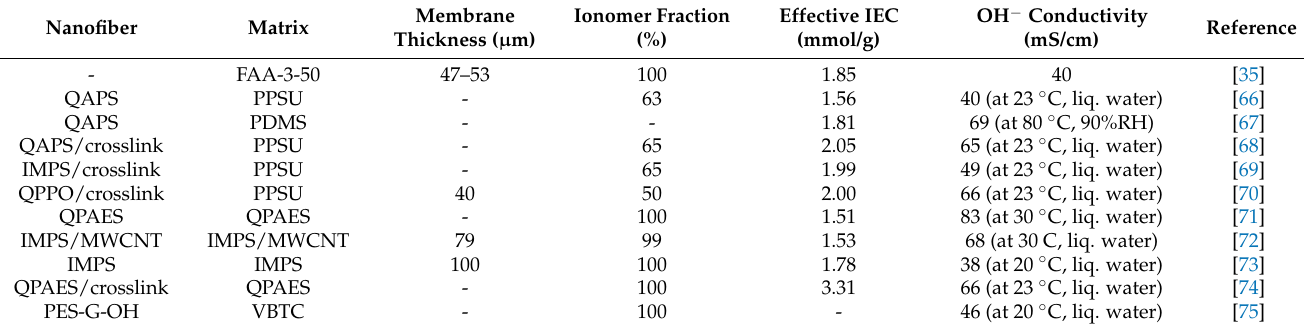
Table 3. Summary of electrospun AEMs and their